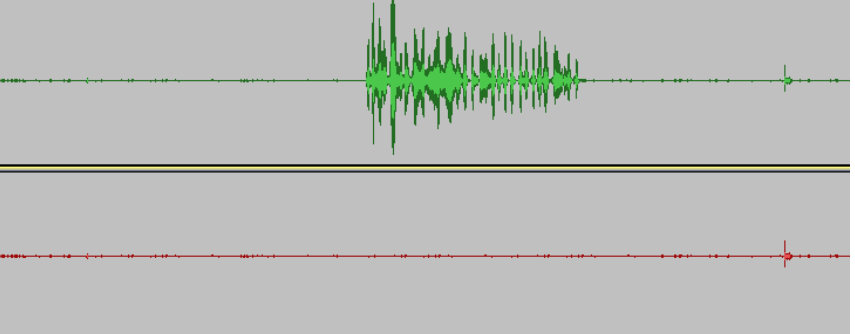
Figure 7. Original audio masked by replay recording of noiseless background recording. The top recording represents the original audio recording and the bottom recording is the duplicated recording after the attack is